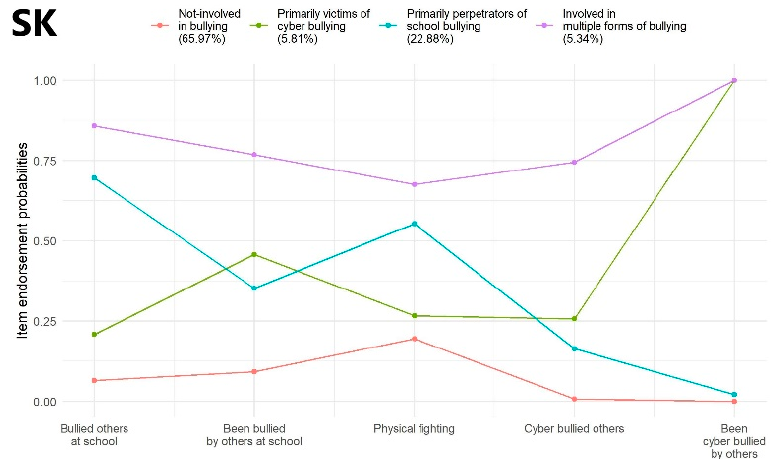
Figure 4. Latent class profile of Slovakia.